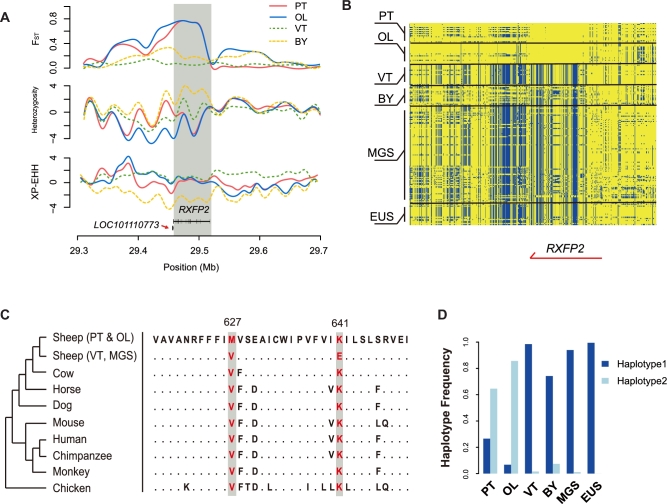
Selective sweep over the horn-related gene RXFP2. a) Statistics plotted over a approximately 400-kb region surrounding RXFP2, including 1) population differentiation (FST) between PT, OL, VT, and BY vs MGS; 2) intrapopulation heterozygosity in PT, OL, VT, and BY, calculated as Z-transformed log2(HP|PT, OL, VT or BY/HP|MGS); 3) haplotypic length measured by Z-transformed XP-EHHPT, OL, VT or BY vs. MGS. b) Haplotypic distributions among 99 sheep of a local region of RXFP2 (chromosome 10: 29 400 000–29 550 000 bp). Biallelic SNPs are shown in blue and yellow. c) Alignment of the RXFP2 protein sequences from 9 vertebrate species. Two protein variants (RXFP2: 627 and 641) with top FST in PT and OL are indicated in red. For 627, PT and OL have the variant allele, whereas for 641, they have the reference allele. The dots in the alignment denote amino acids that are identical with those in PT and OL. d) Distribution of the haplotype frequency of 2 protein-altering variants (RXFP2: 627 and 641) in 1155 sheep. “Haplotype1” corresponds to V627 + E641 (OAR10_29 461 968: C + OAR10_29 462 010: C) and “Haplotype2” corresponds to M627 + K641 (OAR10_29 461 968: T + OAR10_29 462 010: T).